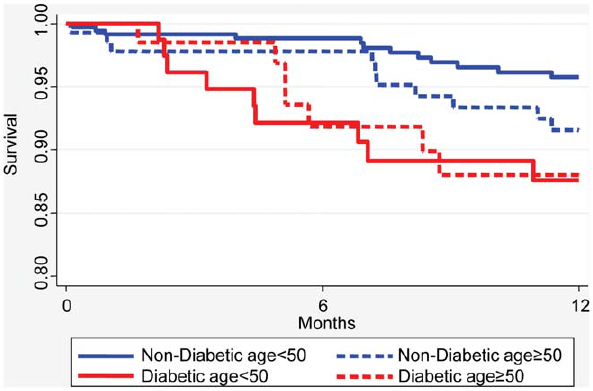
Figure 2. Survival estimates. Unadjusted Kaplan-Meier survival curve for all causes of death in diabetic subjects ( red lines ) and non- diabetic subjects ( blue lines ) grouped by age $ 50 ( dashed lines ) or age , 50 ( solid lines ). Separate curves by age (dashed vs. solid) and diabetes (red vs. blue) illustrate the interaction of diabetes and age on survival. For age , 50 the separation between diabetic vs. non-diabetic subjects is larger than for age $ 50. doi:10.1371/journal.pone.0058044.g002 PLOS ONE |